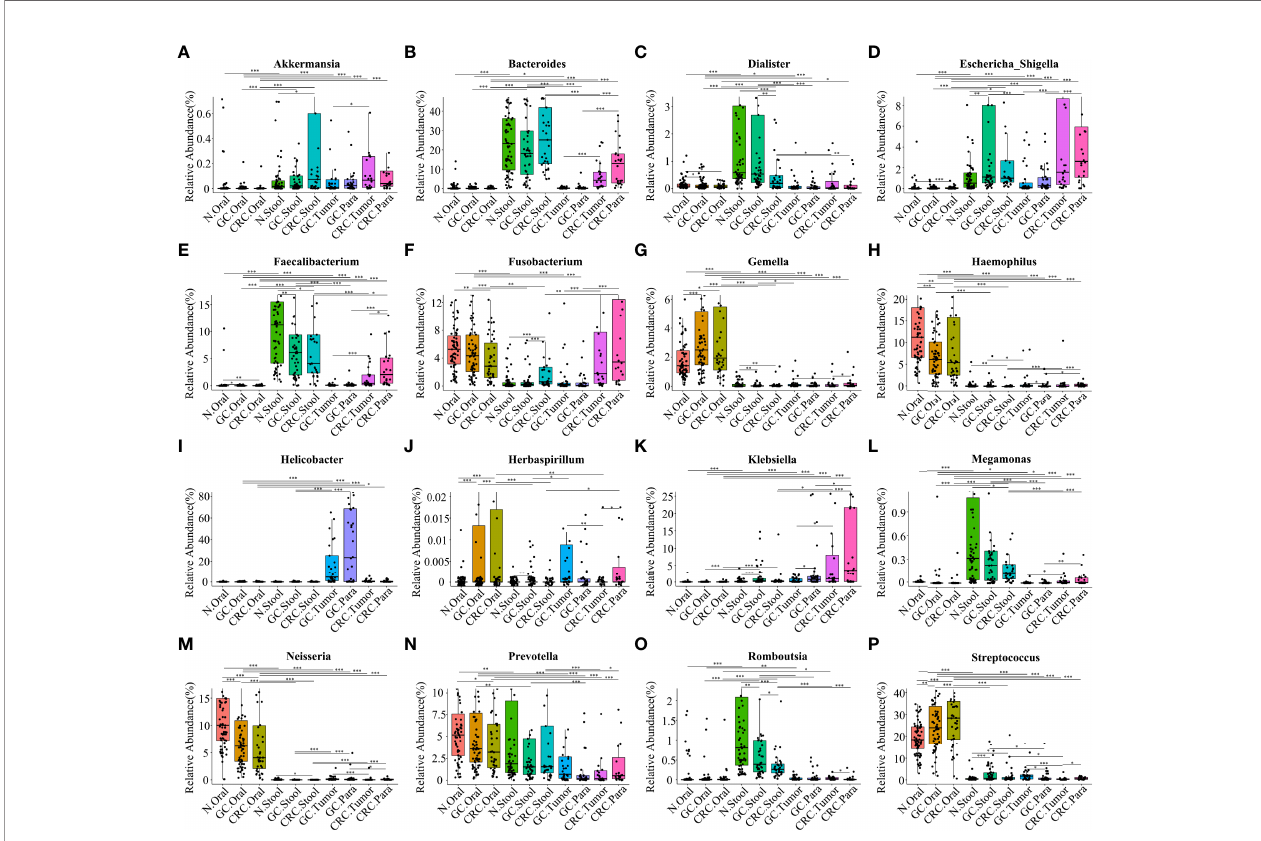
FIGURE 6 | Comparison of the relative abundance of different bacterial genera (LDA > 4) among multiple groups. The results showed the different bacterial genera (LDA > 4) in the oral cavity, feces, and tissues of the HC, GC, and CRC groups: Akkermansia (A) , Bacteroides (B) , Dialister (C) , Escherichia-Shigella (D) , Faecalibacterium (E) , Fusobacterium (F) , Gemella ( G ) , Haemophilus (H) , Helicobacter (I) , Herbaspirillum ( J ) , Klebsiella ( K ) , Megamonas (L) , Neisseria (M) , Prevotella (N) , Romboutsia (O) , and Streptococcus (P) . Compared with the HC oral group, the relative abundance values of Haemophilus (H) and Neisseria (M) in the oral cavity of GC and CRC patients were signi fi cantly downregulated; the relative abundance values of Gemella (G) , Streptococcus (P) , and Herbaspirillum (J) were signi fi cantly upregulated. Compared with the HC oral stool group, the relative abundance values of Dialister (C) , Faecalibacterium (E) , Megamonas (L) , and Romboutsia (O) in the stool of GC or CRC patients were signi fi cantly downregulated; the relative abundance values of Streptococcus , Escherichia-Shigella (D) , Fusobacterium (F) , and Akkermansia (A) were signi fi cantly upregulated. Helicobacter (I) , Bacteroides (B) , Klebsiella (K) , and Prevotella (N) are also different genera in GC and CRC tissues, and their relative abundance values have also changed. *p < 0.05, **p < 0.01, ***p <